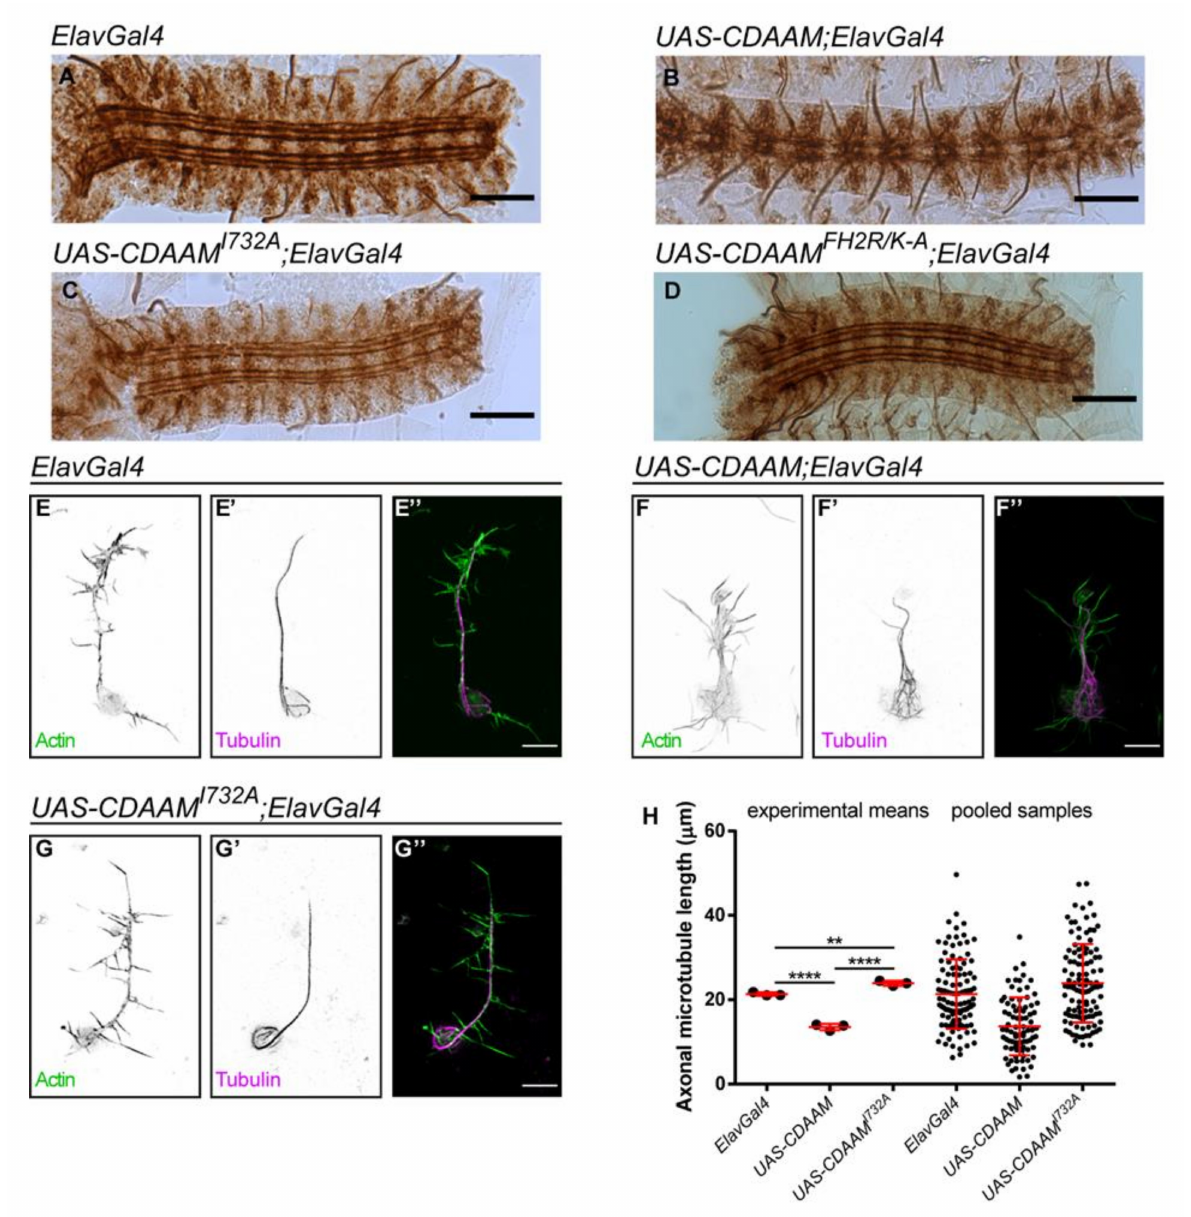
Figure 8. The effect of CDAAM overexpression on neuronal morphology. ( A – D ) Morphology of the FasII-positive motoraxons in the ventral nerve cord of control ( Elav-Gal4 ) ( A ), CDAAM ( B ), CDAAM I732A ( C ) and CDAAM FH2R/K-A ( D ) expressing Drosophila embryos. Scale bar represents 50 µ m. ( E – G (cid:48)(cid:48) ) Representative images of axonal and growth cone morphology of primary neurons derived from control ( E – E (cid:48)(cid:48) ), CDAAM ( F – F (cid:48)(cid:48) ) or CDAAM I732A ( G – G (cid:48)(cid:48) ) expressing Drosophila embryos. The actin cytoskeleton was labelled by phalloidin (green), and microtubules were detected by an anti-tubulin antibody (magenta). Scale bar represents 5 µ m. ( H ) Statistical analysis of the length of axonal microtubule bundles. Scatter plots show the values of the individual cells and the means of the independent experiments. ANOVA was used for statistical analysis. Tukey’s post hoc test was used for multiple comparison. ** p < 0.01, **** p <